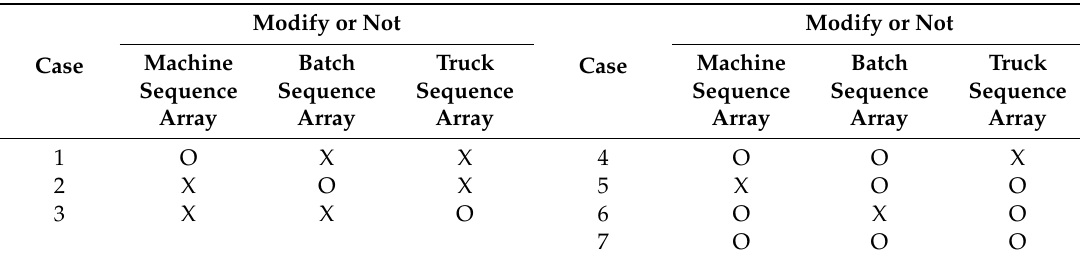
Table 3. The modification